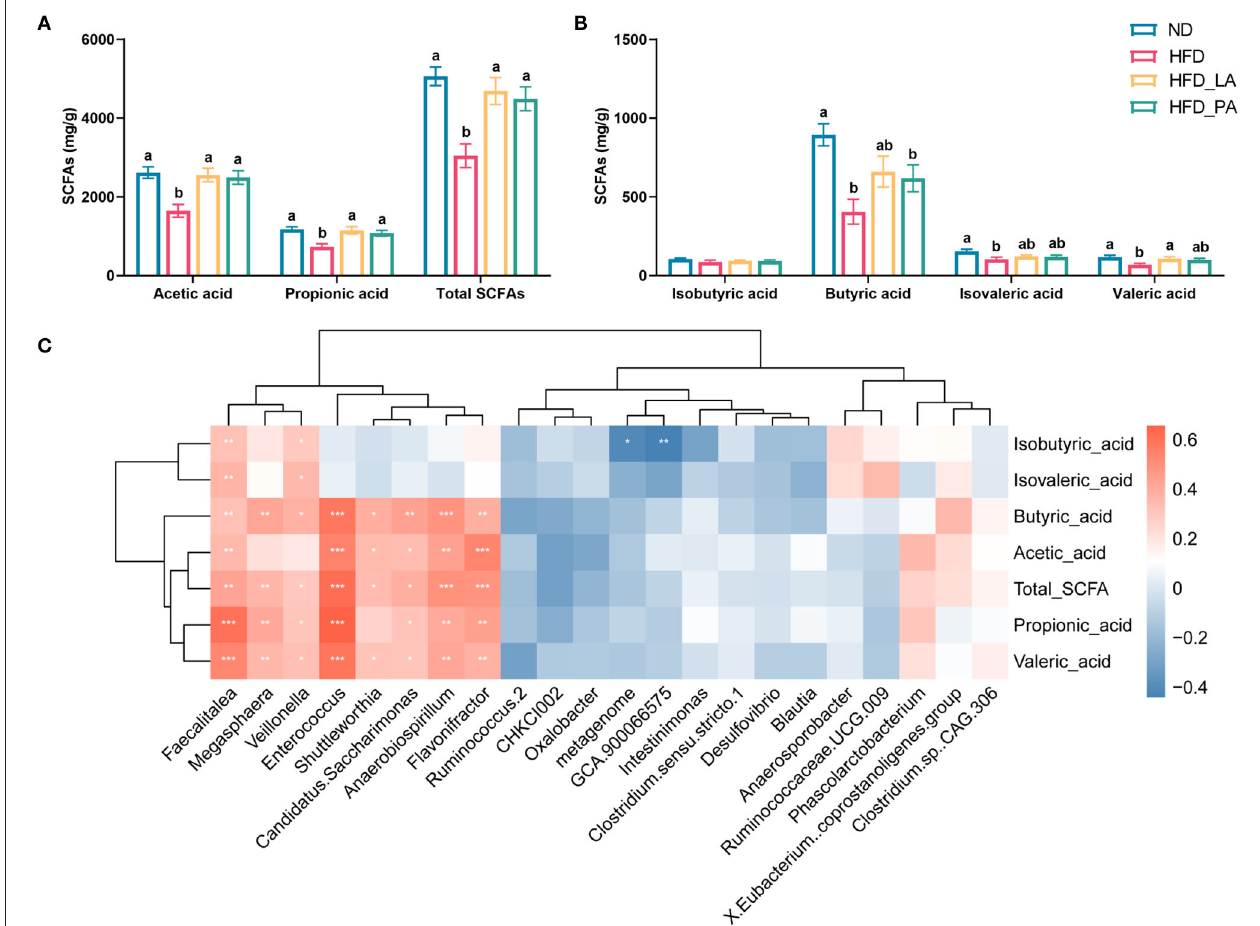
FIGURE 5 | Akkermansia muciniphila treatment increased the cecal short-chain fatty acid (SCFA) content in laying hens with fatty liver hemorrhagic syndrome (FLHS) ( n = 10). (A,B) SCFA contents in the cecum. Different letters indicate significant differences at p < 0.05. (C) Correlation analysis between SCFA contents and the microbial species showed significant differential abundance between groups. Red represents positive correlations and blue represents negative correlations. * p < 0.05, ** p < 0.01, *** p <